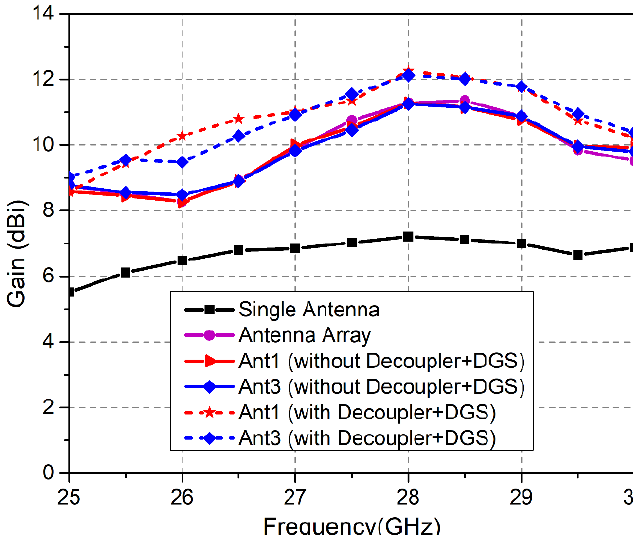
Figure 8. Simulated gain values of the antenna at different design stages.